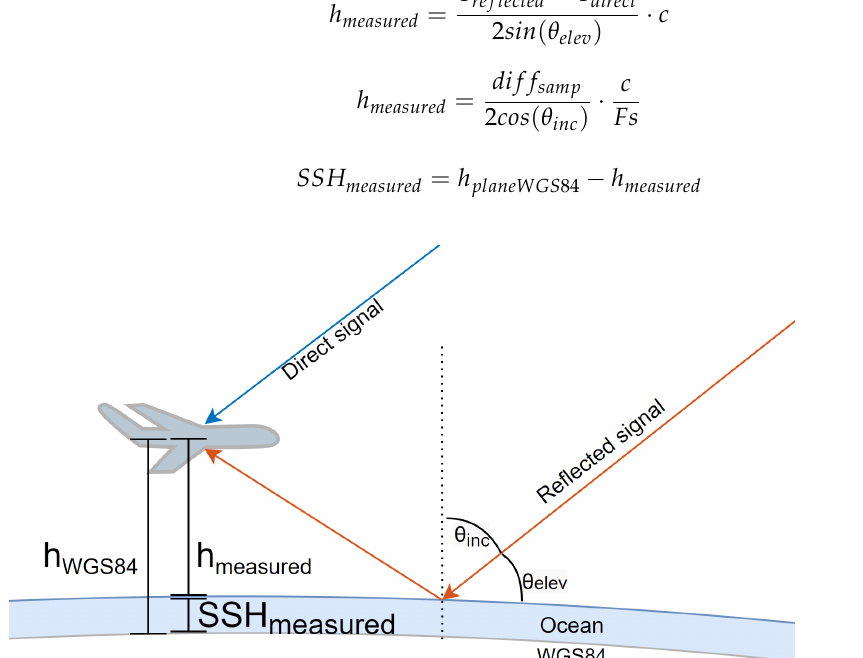
Figure 4. Diagram representing the different magnitudes involved in Equations